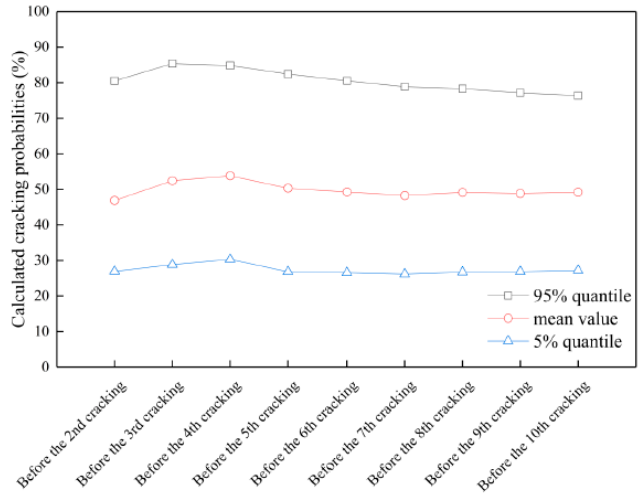
Figure 14. The mean values and confidence intervals of the calculated probabilities at the cracking times for all the past cracking events. For verifying the ability of the proposed methodology in early warning of crest cracking, the cracking times for the observed crest cracking events (the first crest cracking event is excluded) are estimated by Equation (4) using the mean values and the 5% and 95% quantiles of cracking probabilities in Figure 14 with the progressively updated mean value of λ (see Table 5). The estimated mean values (corresponding to the average cracking probabilities) and upper and lower limits (corresponding to the 95% and 5% quantiles of cracking probabilities) of cracking times are shown in Figure 15, where the origin of the time axis (ordinate) corresponds to the beginning of abnormal state, and are compared with the actual cracking times. It is observed that the actual cracking times are between the upper and lower limits of estimated cracking times and are mainly in proximity to the mean values of estimated cracking times. The widths of ranges of estimated cracking times are reduced as the mean value of λ decreases with accumulation of the observed data. However, due to limited observed information and the significantly random nature of the studied problem, the ranges of estimated cracking times are fairly broad. Nevertheless, for the specific dam and the observed crest cracking events, the actual cracking times are essentially located between the mean values and lower limits of estimated cracking times, with which the possible occurrence times for future crest cracking events would be predicted. In dam safety management, it is required to early warn crest cracking event, so that preparation for remediation measures can be made in advance. The early warning of crest cracking could be realized by estimating the lower limit of cracking time using the proposed methodology. Figure 16 shows the early warning times (i.e., the period between the actual cracking time and the estimated lower limit of cracking time) for the crest cracking events. It can be seen that for the specific dam, early warning of crest cracking can be issued from 20 days to 70 days ahead of the occurrence of crest cracking event.